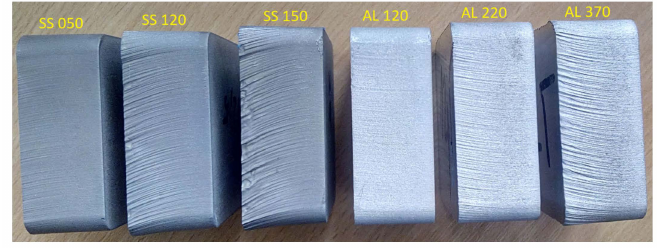
Figure 3. Experimental samples used.